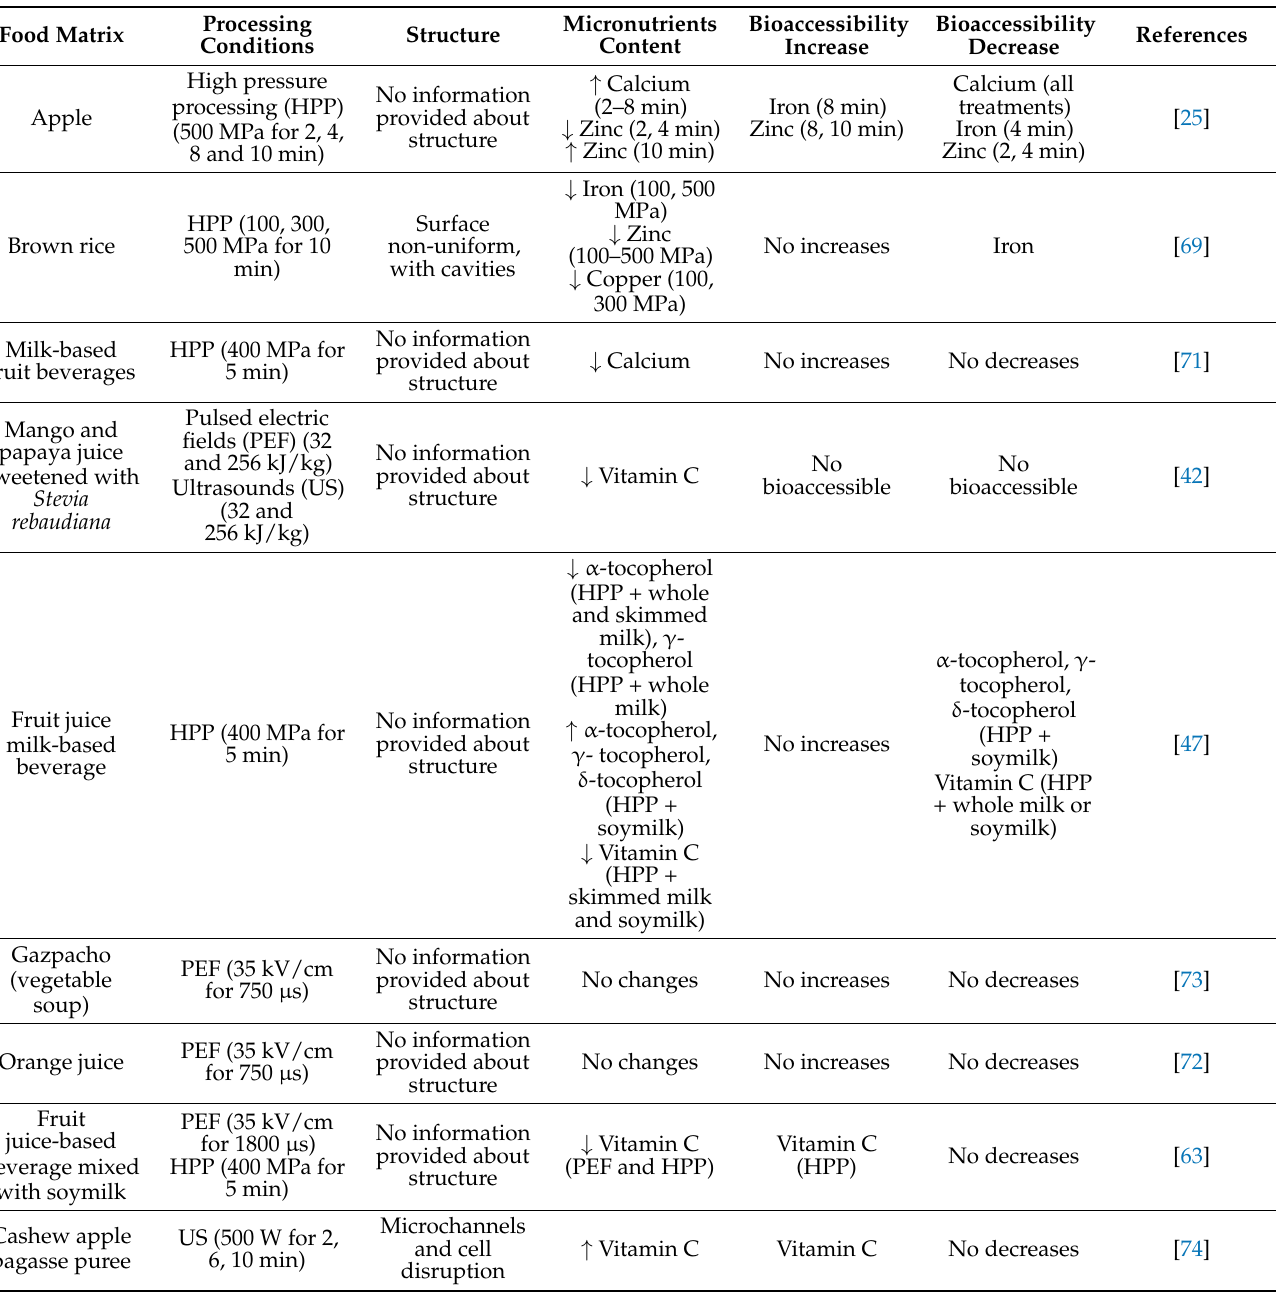
Table 3. Micronutrients content, bioaccessibility, and structure of selected plant foods as affected by non-thermal processing. Food